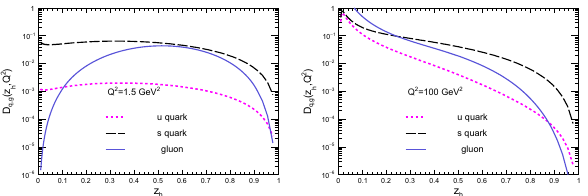
Fig. 1 Parton FFs of the φ meson as a function of z h at the initial scale Q 2 = 1 . 5 GeV 2 ( left panel ), and at the scale of Q 2 = 100 GeV 2 ( right panel )